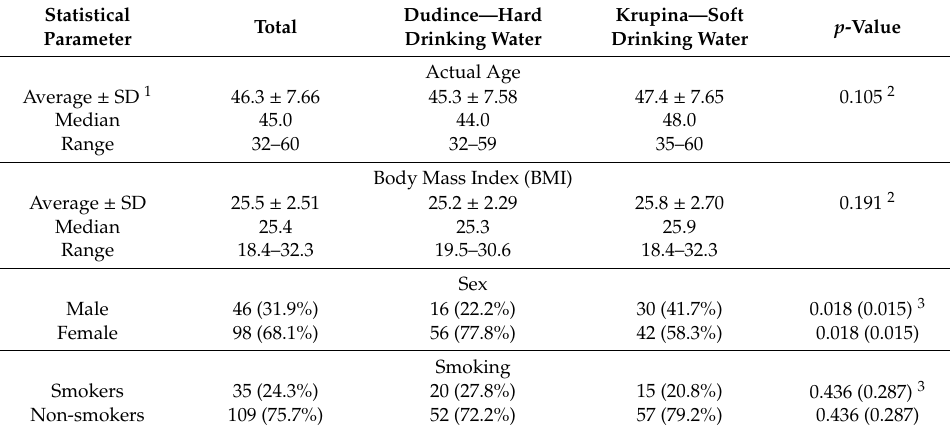
Table 2. Summary of basic characteristics of participants involved in the